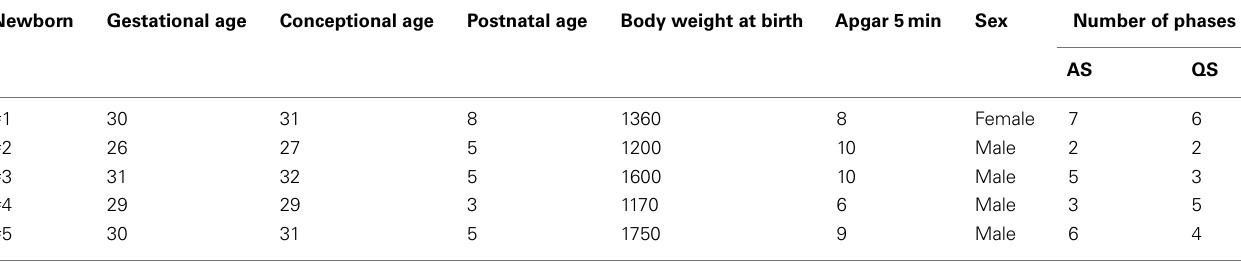
Table 1 | Demographic characteristics and number of extracted sleep states of the five preterm